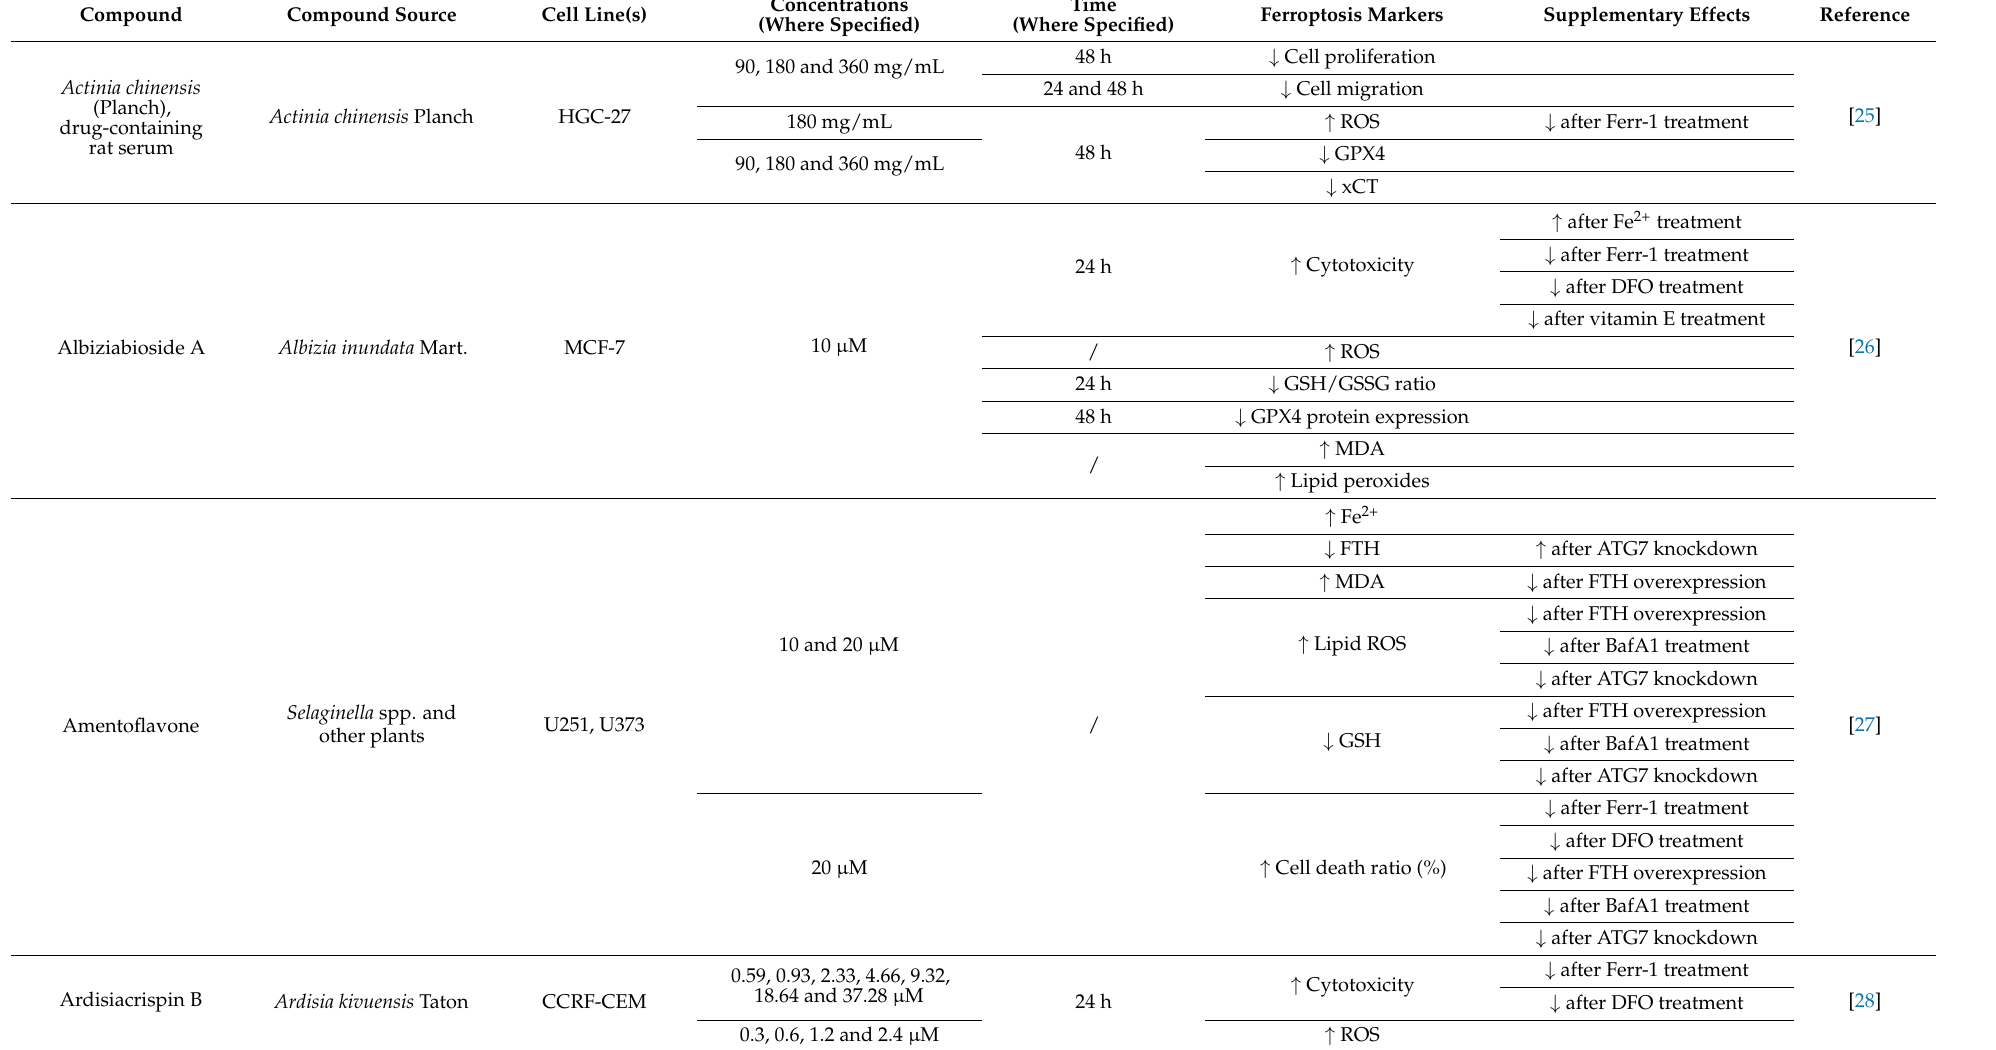
Table 1. Natural products as in vitro inducers of